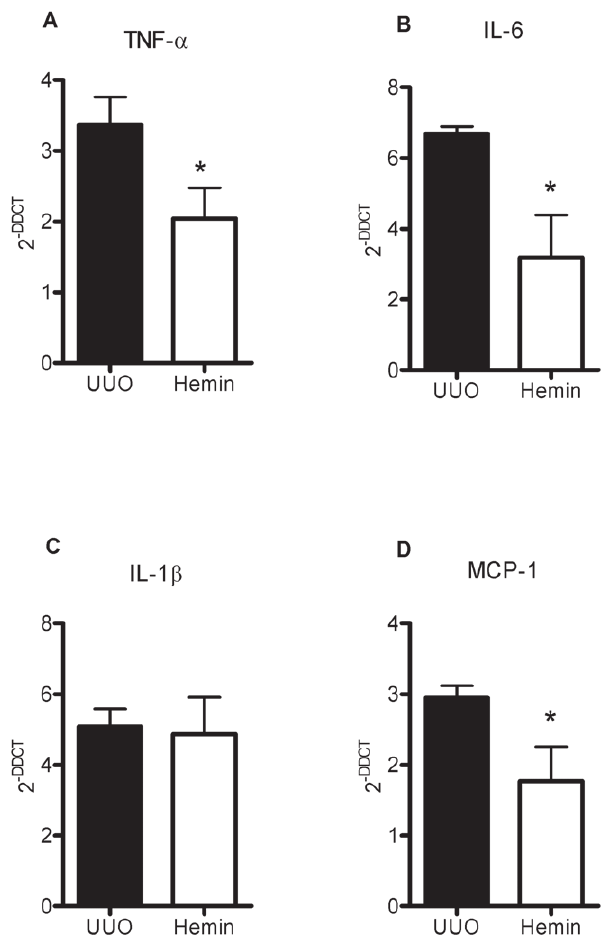
Figure 10. Induction of HO-1 after 7 days of UUO is capable of reducing the signaling molecules involved in the inflammatory process. Geneexpression of TNF- a (panel A),IL-6 (panel B),IL-1 b (panel C) andMCP-1(panelD) wereassessedbyRT-PCR(shownas average 6 s.e.m.). Samples were obtained from the obstructed kidneys of UUO and Hemin- treated animals. Renal tissue was collected from animals that did not undergo ureter obstruction surgery and were used as control. Messenger RNA from control animals was assigned a value of 1. * p , 0,05 vs.